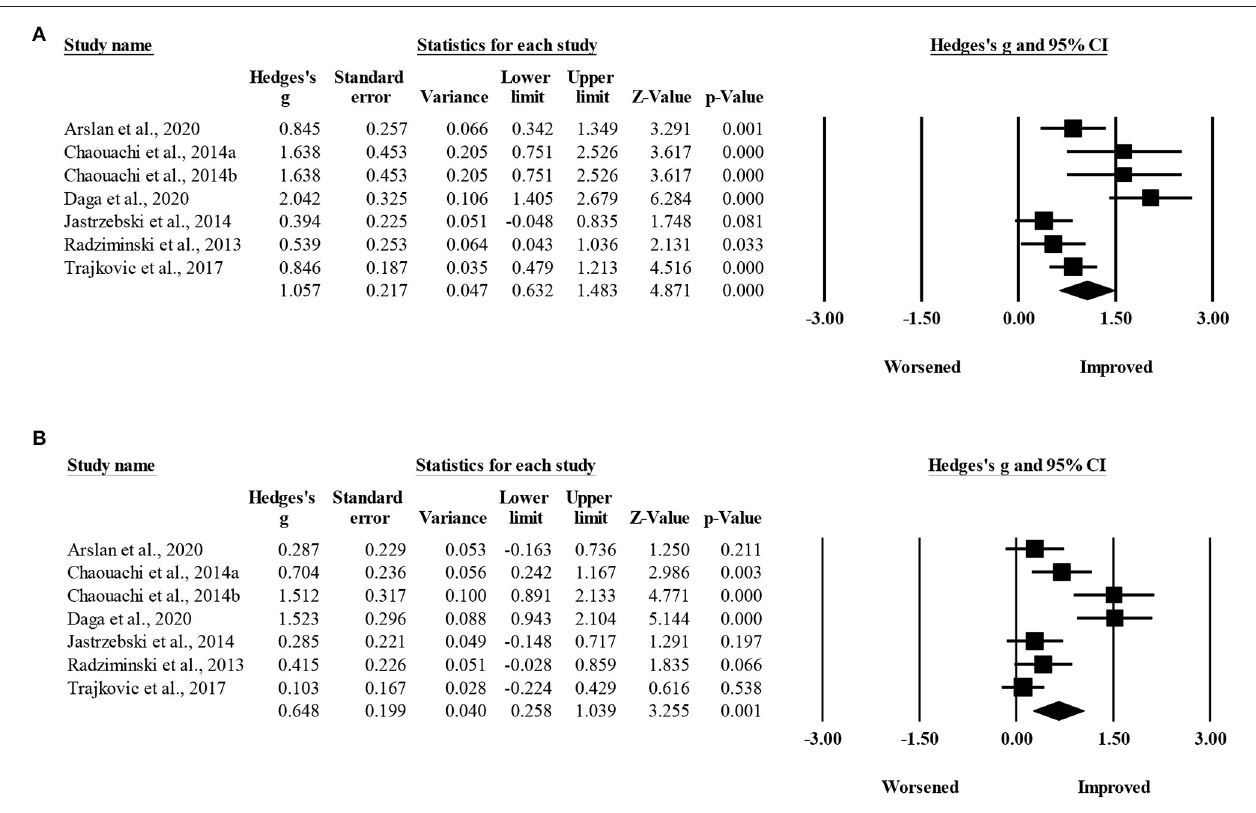
FIGURE 3 | Forest plot of within-group pre-post intervention changes in technical execution, in youth athletes from team sports participating in (A) SSGs-based programs and (B) control condition. Values shown are effect sizes (Hedges’s g) with 95% confidence intervals (CI). The size of the plotted squares reflects the statistical weight of the study. The black diamond reflects the overall